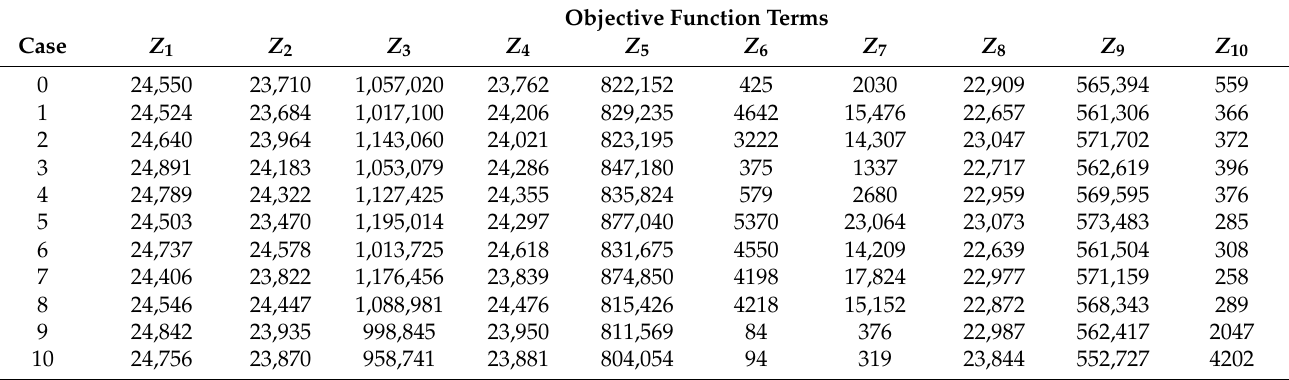
Table 12. Average values of the objective function terms in Problem-4 from ten replications in each cases (Cases 0 to